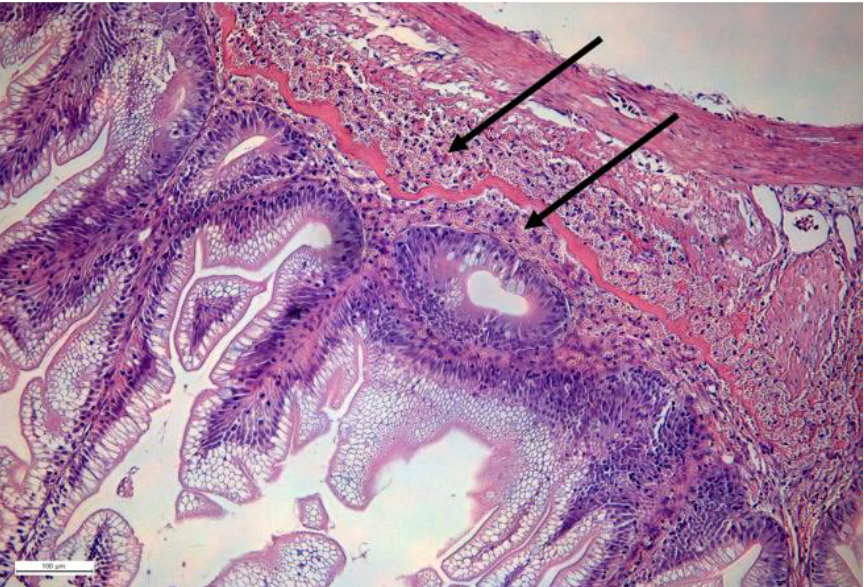
Figure 1. H&E-stained section of salmon intestine. Arrows show localization of EGCs on both sides of the stratum compactum (continuous layer stained red). Courtesy: Lisa Furnesvik and Tore Seternes.